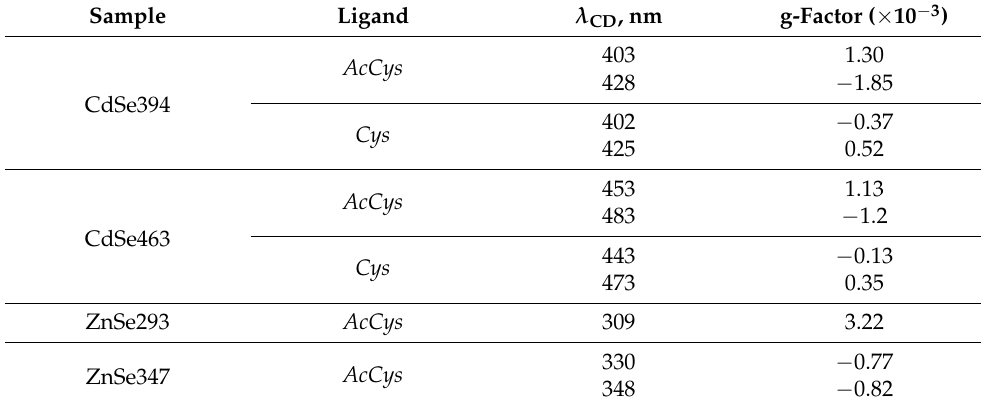
Table 1. Spectral position λ CD and dissymmetry g-factor for the main circular dichroism bands of CdSe and ZnSe samples with different thickness, covered with L-Cys or L-AcCys ligands. Sample Ligand λ CD , nm g-Factor ( × 10 − 3 ) 403 1.30 AcCys 428 − 1.85 CdSe394 402 − 0.37 Cys 425 0.52 453 1.13 AcCys 483 − 1.2 CdSe463 443 − 0.13 Cys 473 0.35 ZnSe293 AcCys 309 3.22 330 − 0.77 ZnSe347 AcCys 348 −